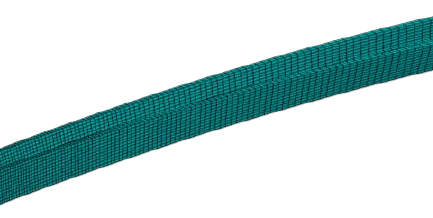
Figure 13. Meshed model of the profile to be straightened.